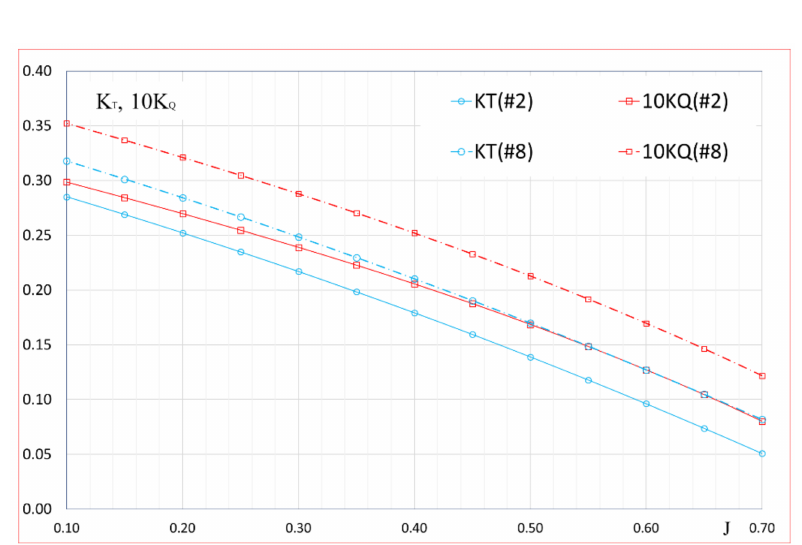
Figure 7. Open-water characteristics of two candidate